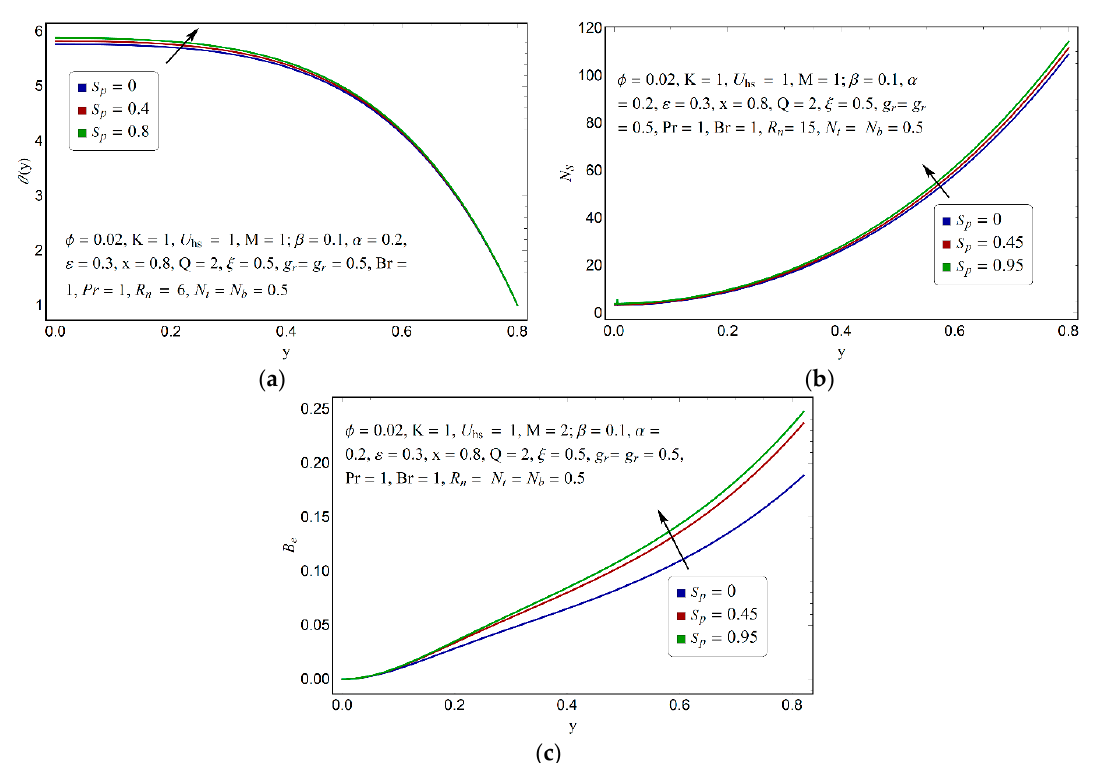
Figure 9. Impact of S p on ( a ) the temperature profile, ( b ) the mass concentration, ( c ) the entropy number, and ( d ) the Bejan number.